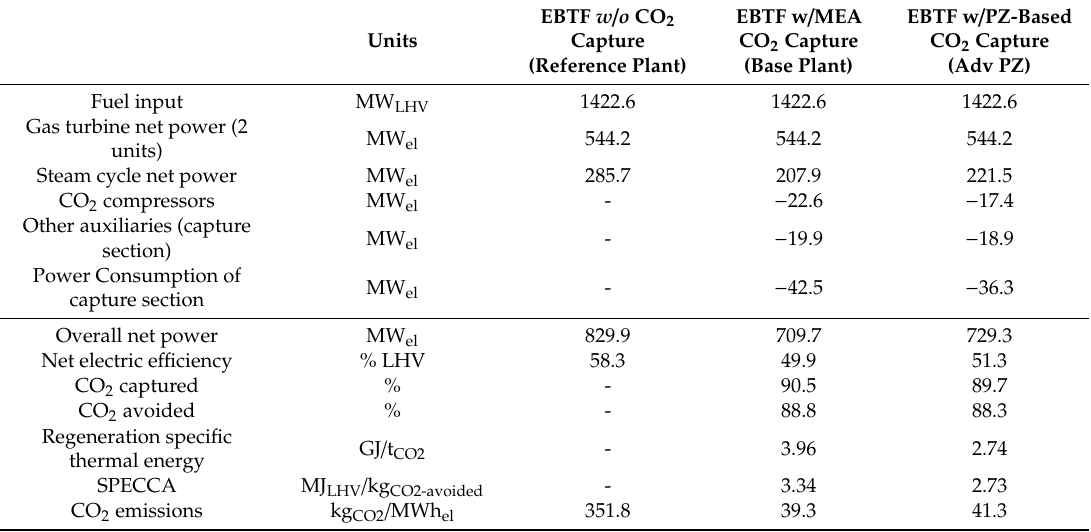
Table 3. Performance of a European Benchmarking Task Force (EBTF) plant without capture, versus monoethanolamine (MEA) or PZ-based capture.